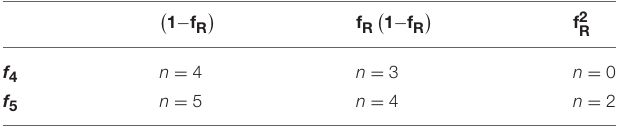
Each row and column combination represent a single RSU species whose likelihood is proportional to the product of the row by column headings and whose connectivity is given by the table entry. The parameters, f i = 4,5, R , represent the fraction of germanium that are 4-, 5-coordinated or participants in 3-membered rings,